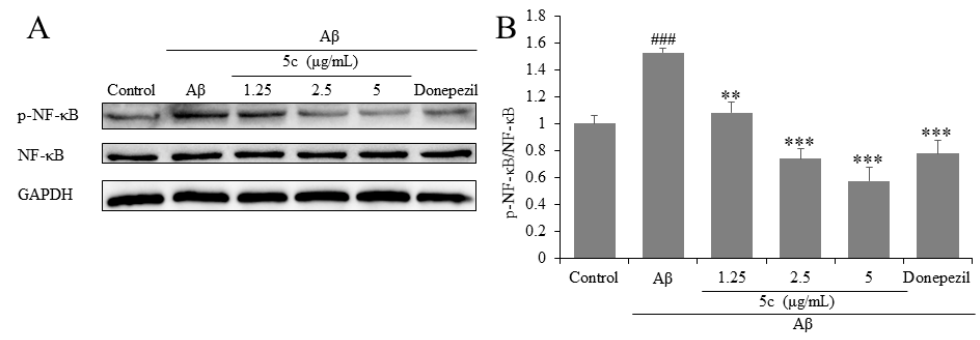
Figure 4. E ff ects on nuclear factor- κ B (NF- κ B) of compound 5c in PC12 cells induced by A β 25-35 . ( A ) The protein levels of NF- κ B were detected by Western blotting. ( B ) Quantification of NF- κ B expression is presented in bar graphs. ### p < 0.001 vs. control group; ** p < 0.01, *** p < 0.001 vs. model group.